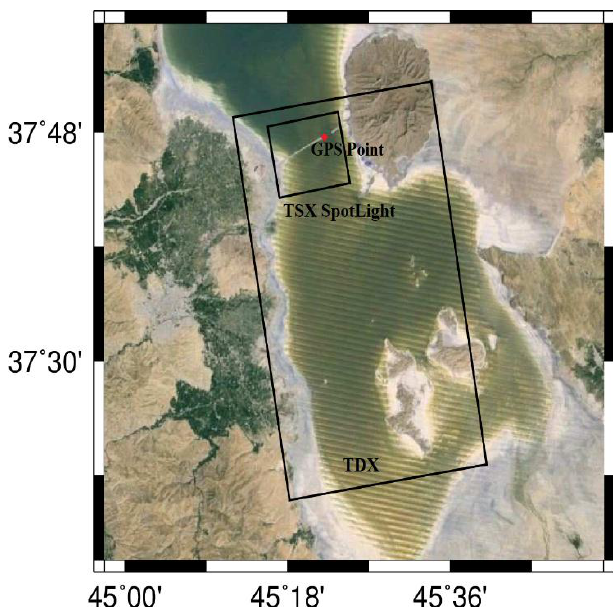
Figure 1. TDX and TSX SpotLight frames used in this study. GPS point has been marked by a red